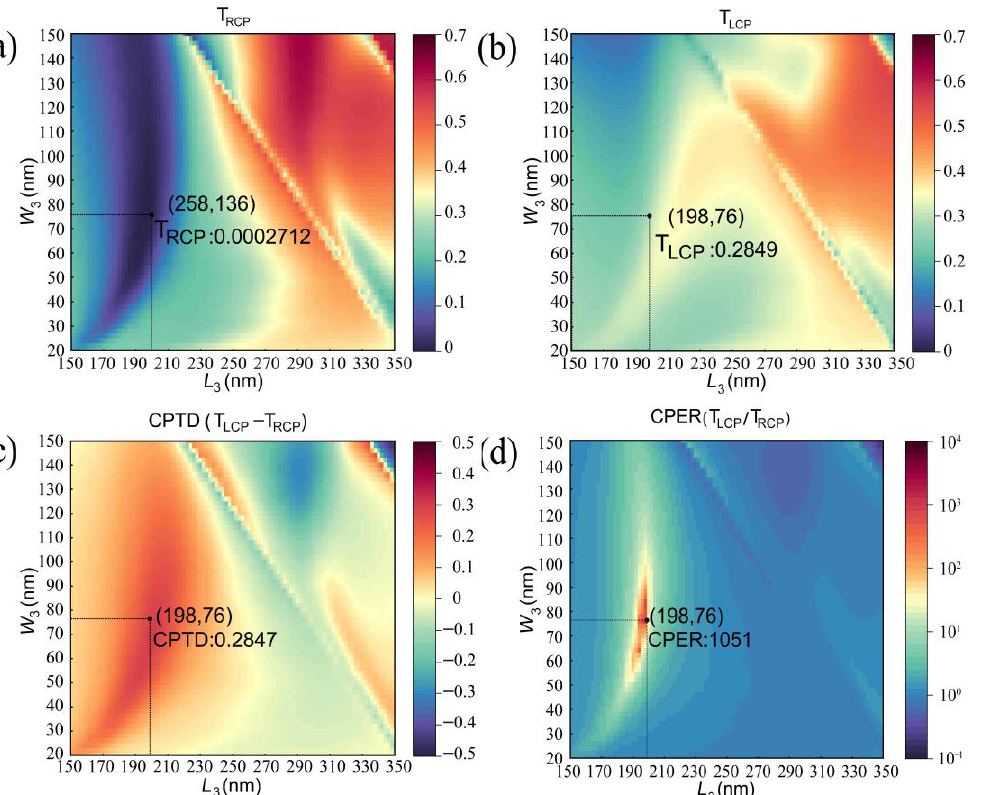
Figure 4. Simulated optical properties of the double orthogonal rectangular slots array. ( a ) The transmittance of the TM and TE linear polarized light ( T Ex and T Ey ) of the double orthogonal rectan- gular slots array. ( b ) The phase mutation of the TM and TE linear polarized light ( P Ex and P Ey ) of the double orthogonal rectangular slots array.